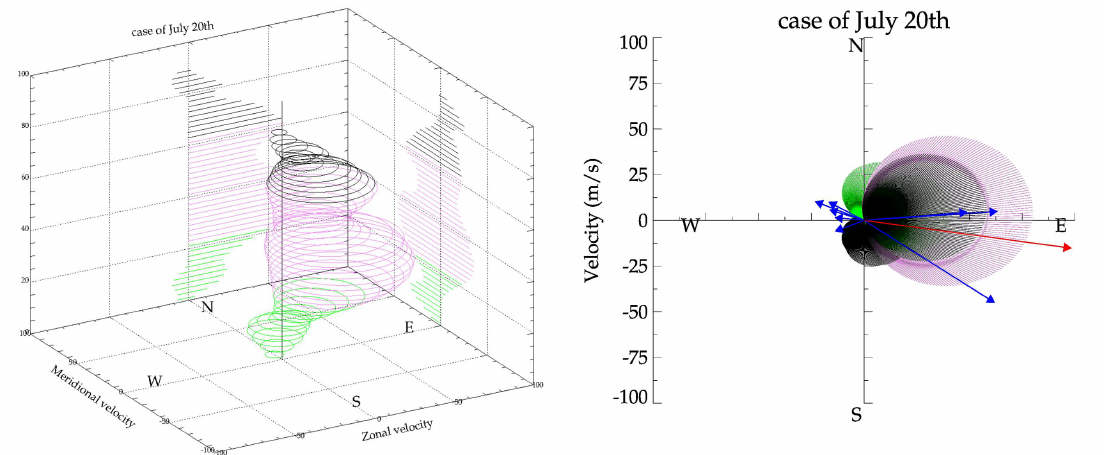
Figure 10. Blocking diagram for the night of July 20–21 (left panel), and its projection at the polar chart (right panel). Blue arrows represents the phase speed and direction of the small-scale gravity waves while the red arrow represents the medium-scale wave phase speed and direction. The used color patterns for the blocking regions are the same as in Figure